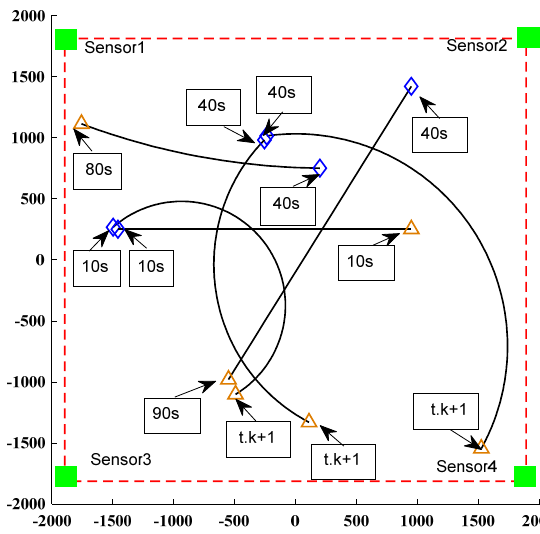
Figure 9. Nonlinear CV model’s moving target trajectory.